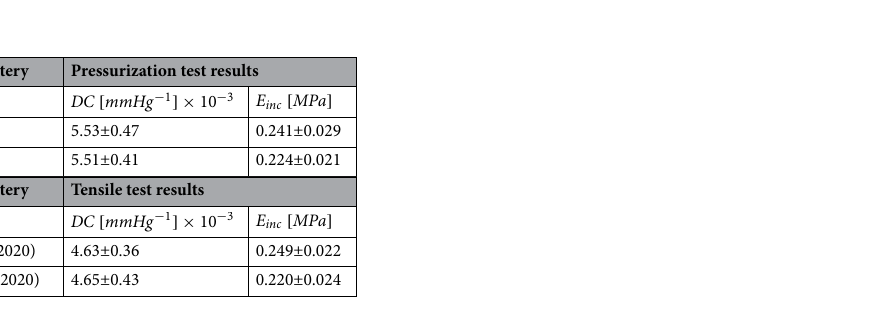
Figure 5e,f shows pressure vs. diametral stretch curves corre- sponding to groups CN and MN for a value of axial stretch (cid:31) z = 1.20 . The experimental response of both groups